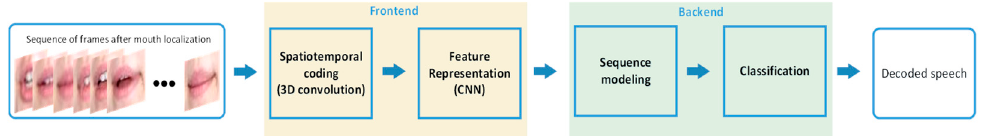
Figure 1. The workflow in the recent Lip Reading (LR) systems based on deep learning. Given an image sequence, the mouth regions are detected and cropped. Then, the frontend consists of a spatiotemporal convolution stage along with a CNN for capturing the short-term dynamics and finally extracting a feature vector for each frame. The features are the inputs of the backend that is composed of the sequence modeling and classification stages. Thus, the information is encoded by a sequence modeling stage, and the output of the sequence modeling is being fed to the classification module, which provides the class probabilities, i.e., the decoded speech.